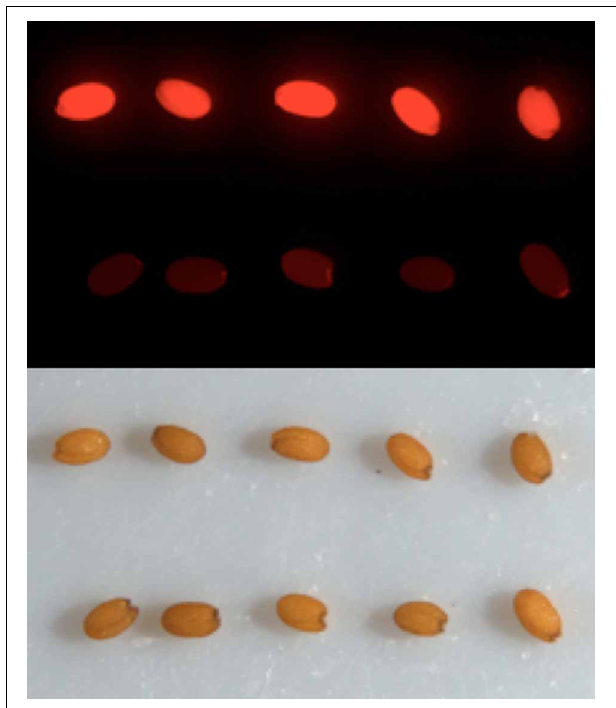
FIGURE 3 | Pro35S:PM-mCherry cassette (pGoldenGate-SE7, pGoldenGate-MCY2) enables the selection of transgenic (top row) vs. non-transgenic (bottom row) seeds. Fluorescence (top image) and bright field (bottom) images are shown.